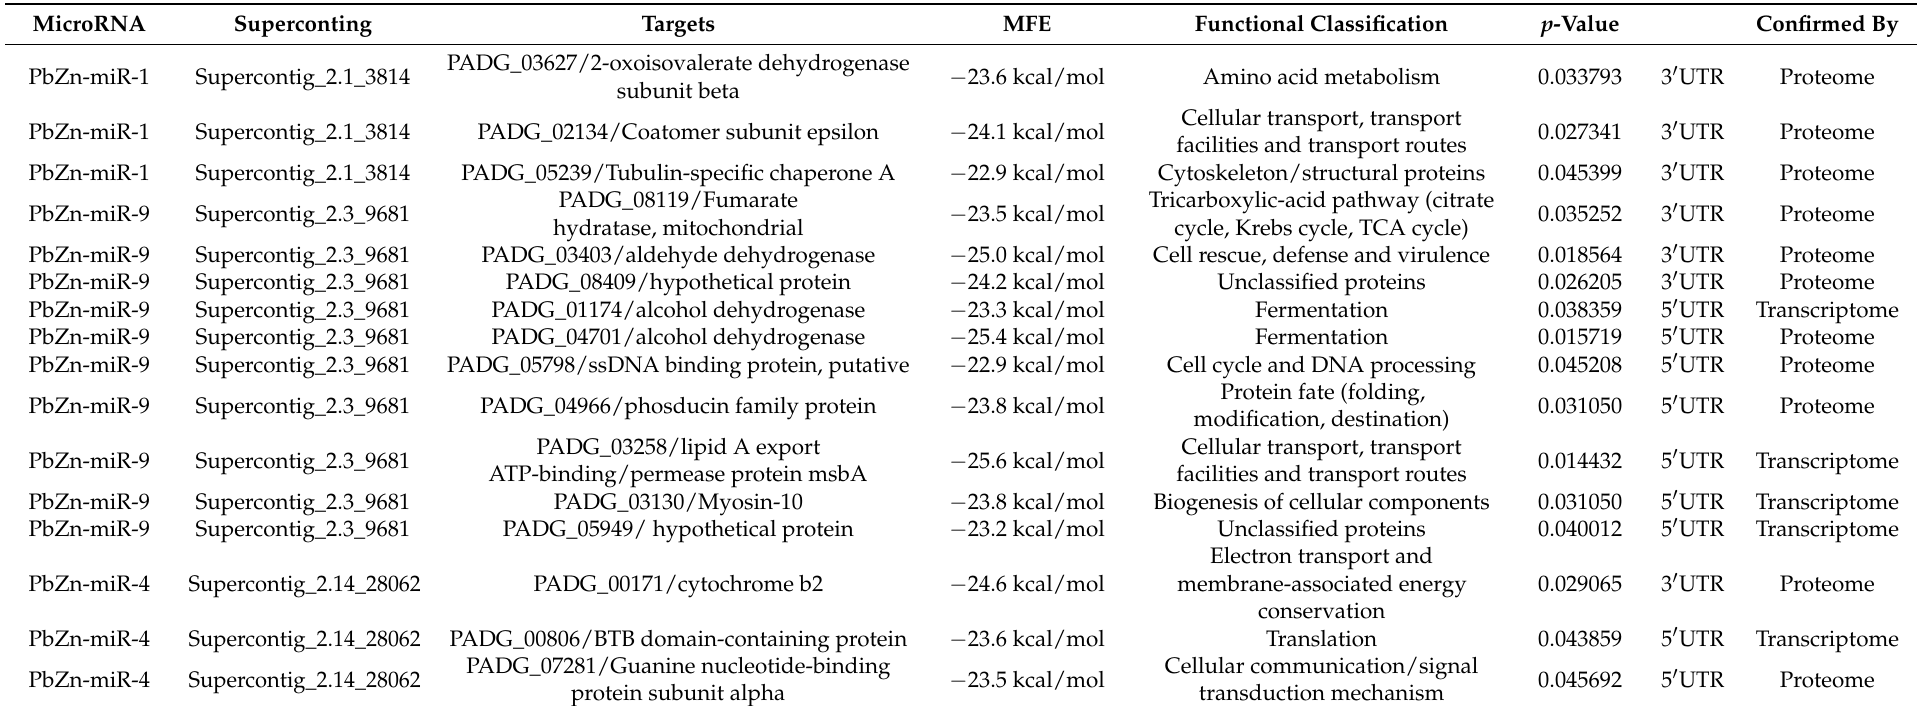
Table 2. Targets of differentially expressed miRNAs confirmed by transcriptional or proteomic